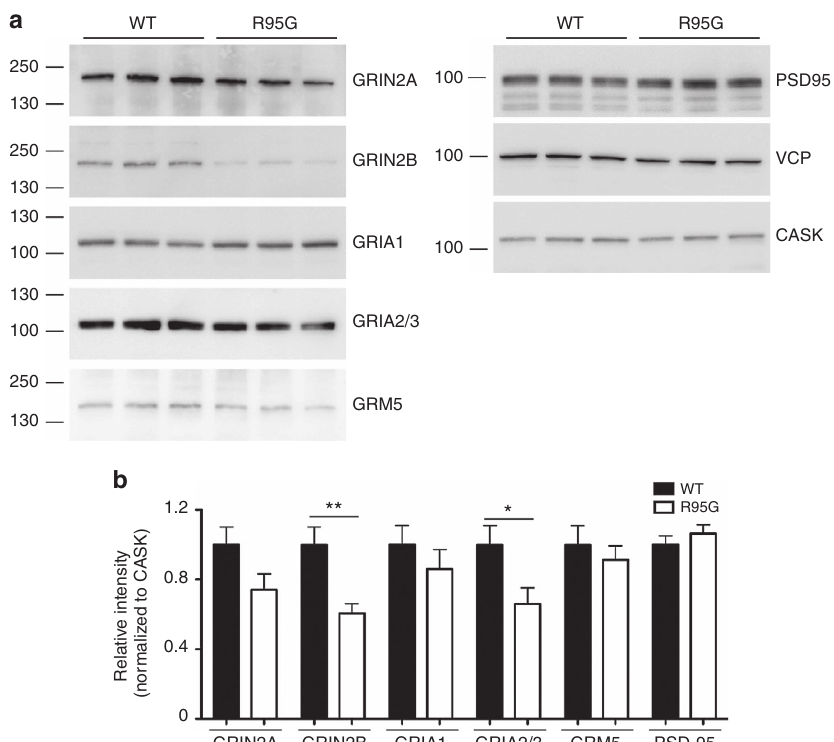
Figure 7 | Expression of synaptic membrane proteins GRIN2B and GRIA2/3 are reduced in VCP R95G knockin mutant neurons. ( a ) Synaptic protein expressions of hippocampal neurons from WTand VCP R95G mice at 18 DIV. ( b ) Quantification of ( a ), normalized with CASK. Extracts collected from a total of six different mice for each genotype are compared. The data are presented as the mean þ s.e.m. (error bars). * P o 0.05; ** P o 0.01; unpaired t -test. Images have been cropped for presentation. Full-size images are presented in Supplementary Fig.